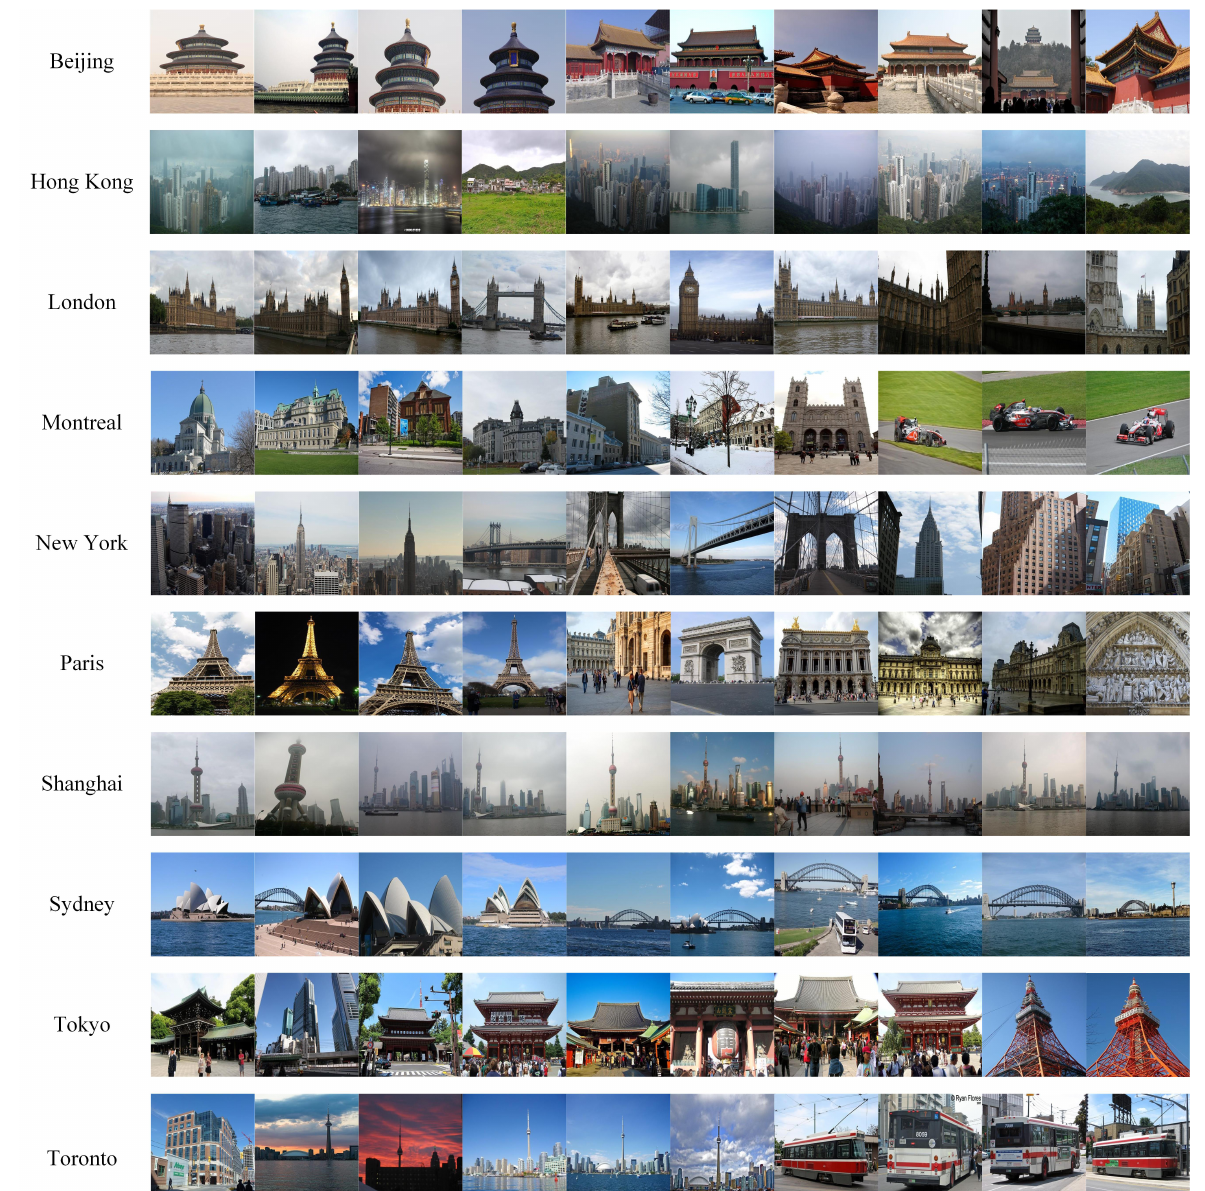
Figure 4. Samples of each city with unique visual